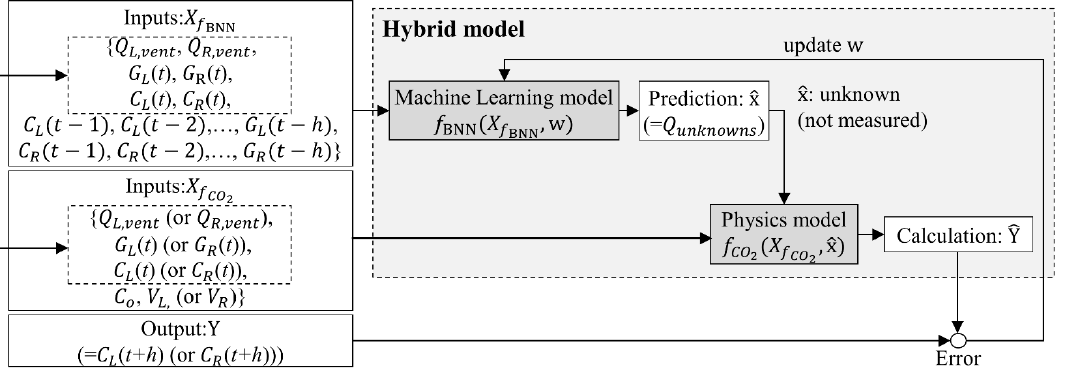
Figure 2. Concept and learning process of the hybrid model for forecasting indoor CO 2 concentration; the inputs in the white box shown with a dotted line have identical values and are entered into f CO 2 and f BNN